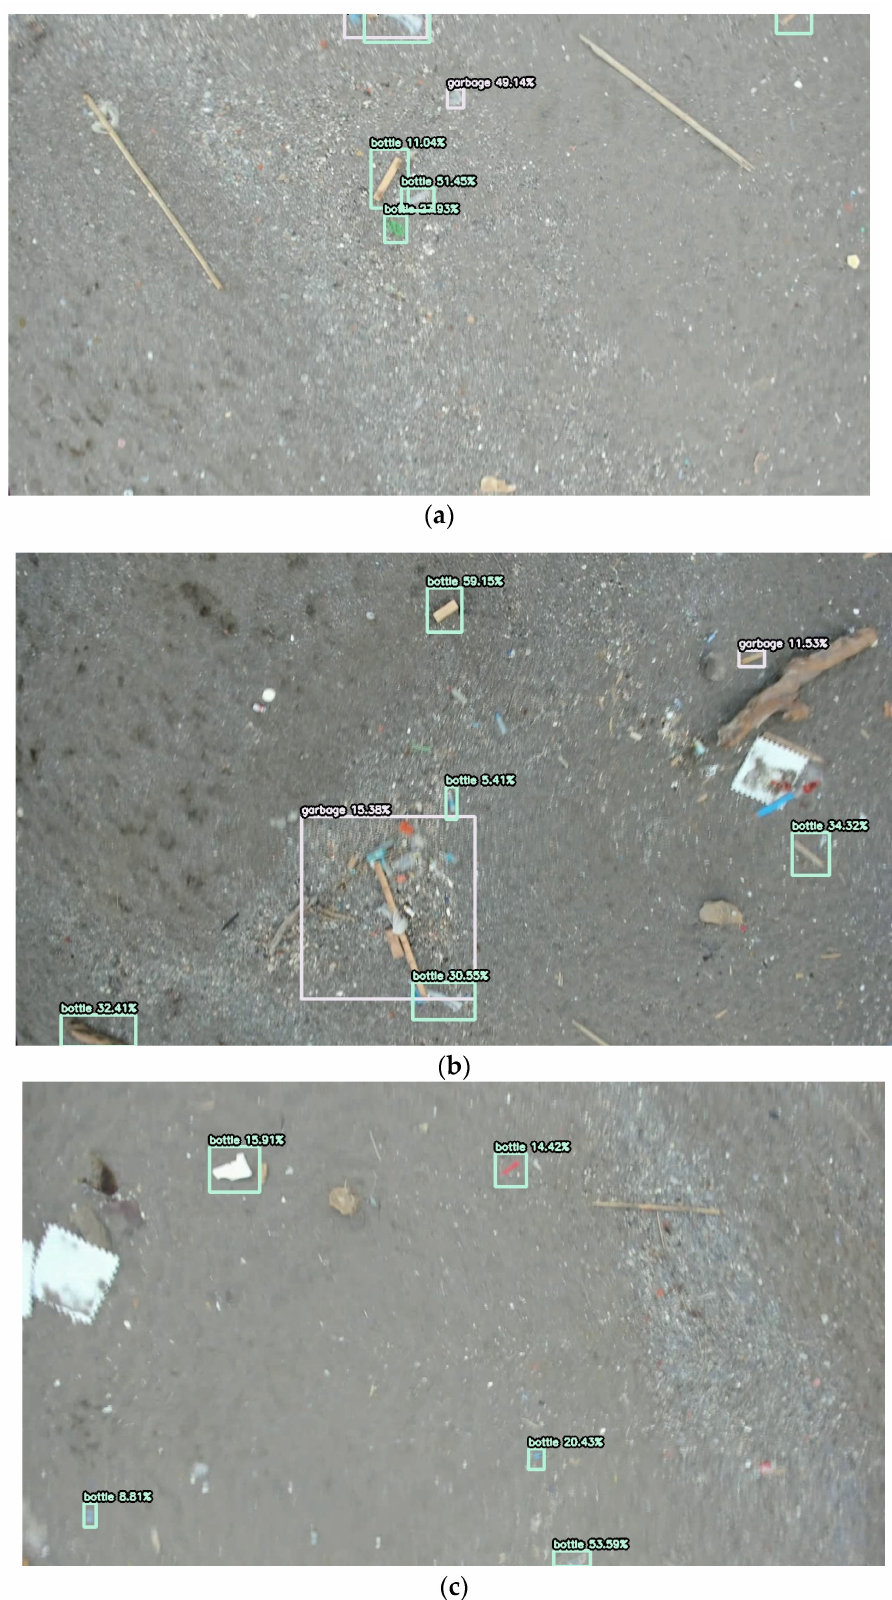
Figure 14. Trash detection at Wanghai Xiang beach. ( a ) The detection result of the trash detector at location 1. ( b ) The detection result of the trash detector at location 2. ( c ) The detection result of the trash detector at location